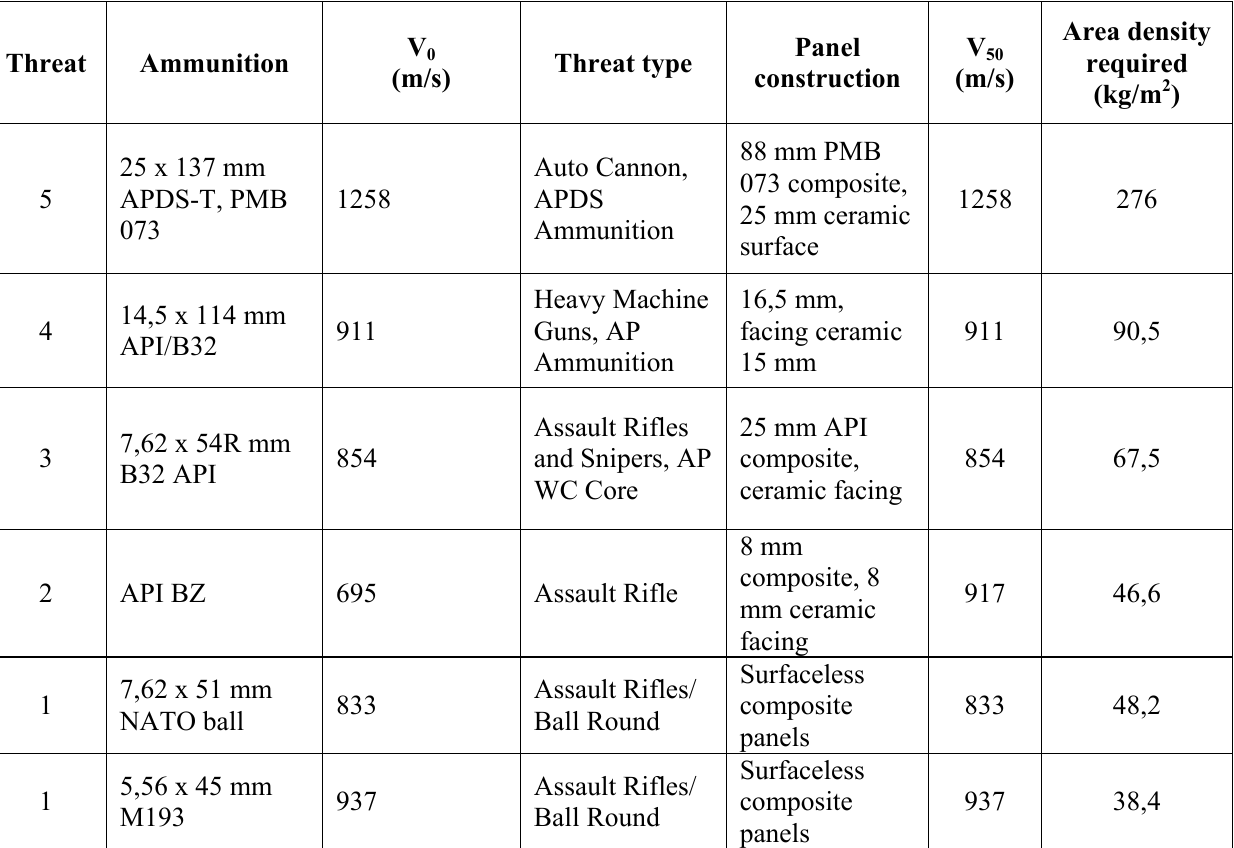
Table 3. Threat Solutions and Composite Protection Levels for STANAG 4569